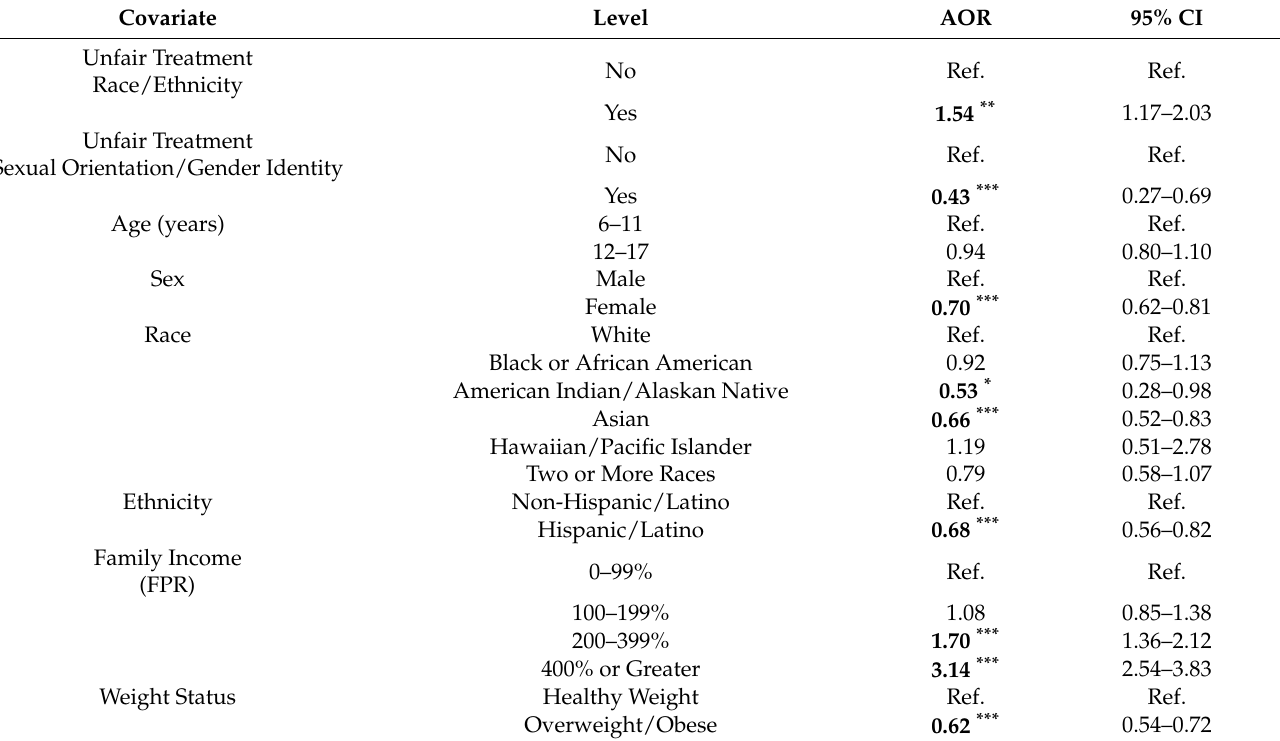
Table 4. Adjusted odds ratios from the weighted multivariable logistic regression